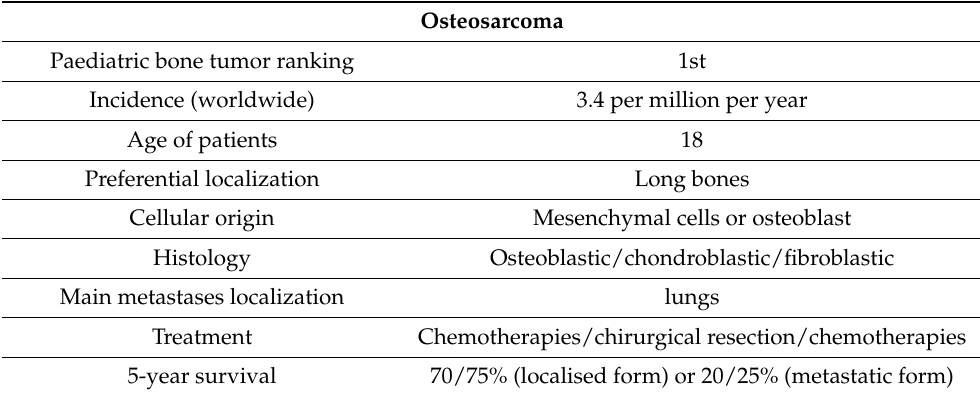
Table 1. Main features of